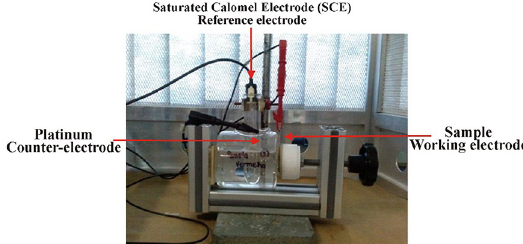
Figure 2. Electrochemical cell with three electrodes used in electrochemical